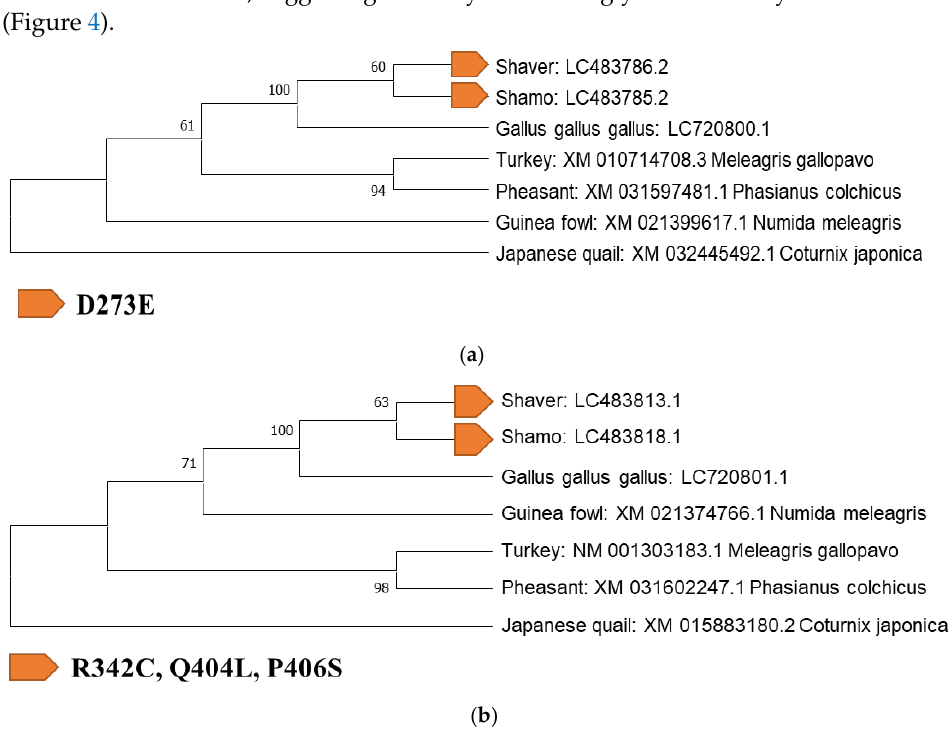
Figure 3. Phylogenetic analysis of the adrenergic receptor (ADR) genes ADRα1D ( a ) and ADR β1 ( b ).